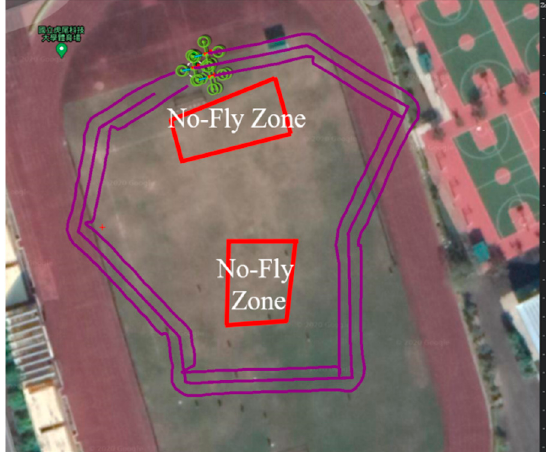
Figure 18. Formation mission simulation results.